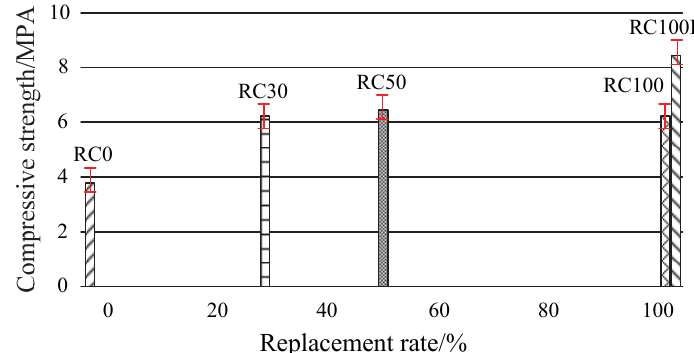
Figure 4: The diagram of the relationship between different replacement rate and compressive strength.